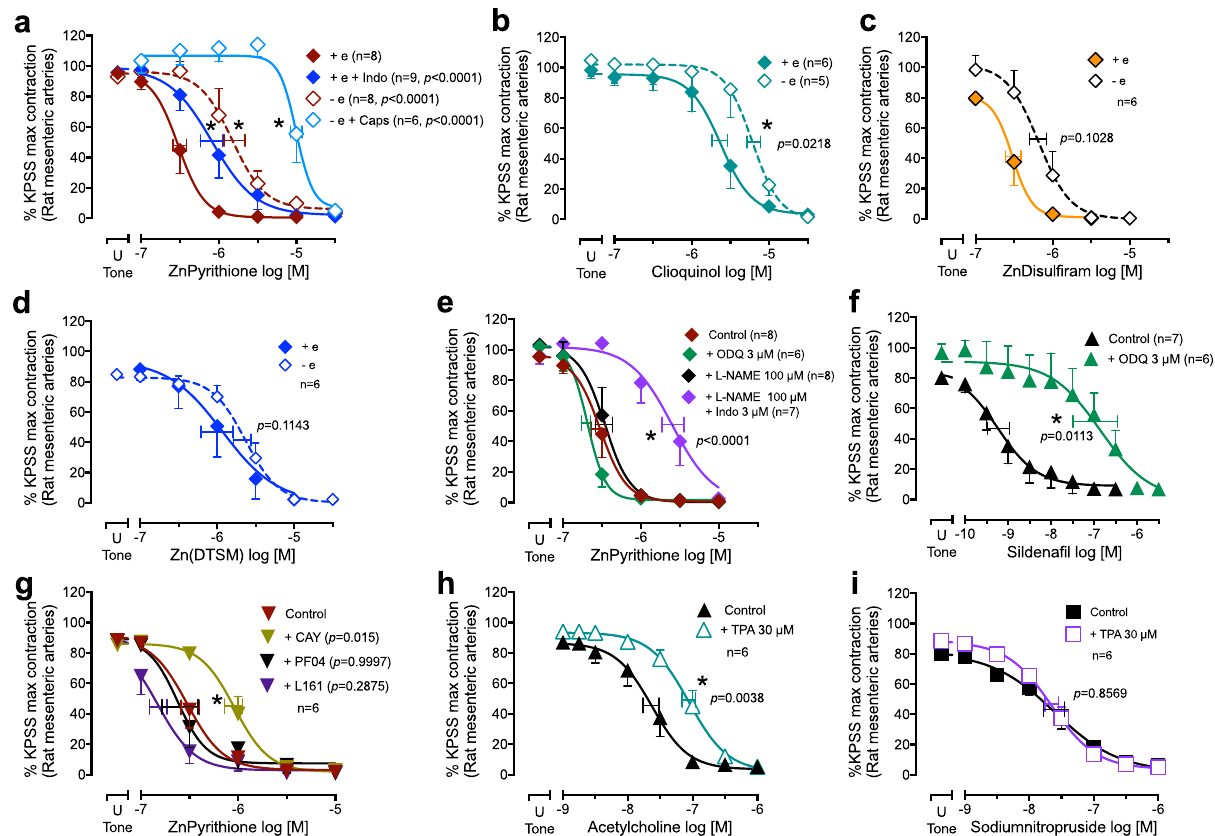
Fig. 5 Effects of endothelium-dependent mechanisms on zinc ionophore-dependent vasorelaxation. a Effects of zinc pyrithione with/without endothelium ( + / − e), cyclooxygenase inhibition (indomethacin, Indo 3 µ M), and capsaicin desensitization (caps, 10 µ M followed by washout). b – d Impact of endothelial denudation on zinc-dependent relaxation by clioquinol ( b ), zinc disul fi ram ( c ), or Zn(DTSM) ( d ). e Inhibition of nitric oxide